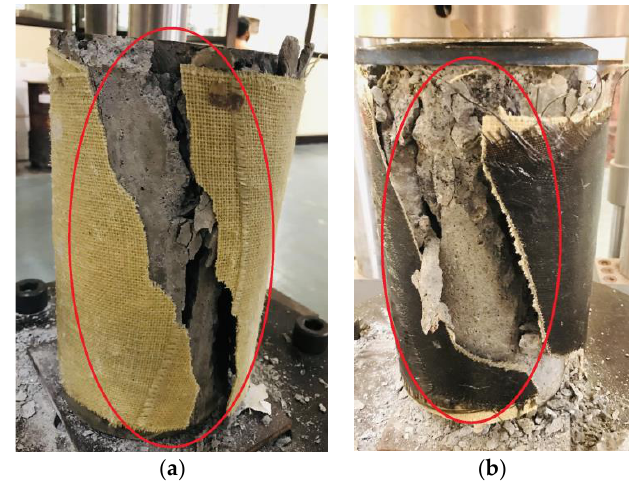
Figure 6. Failure pattern of ( a ) C-C0S2 ( b )